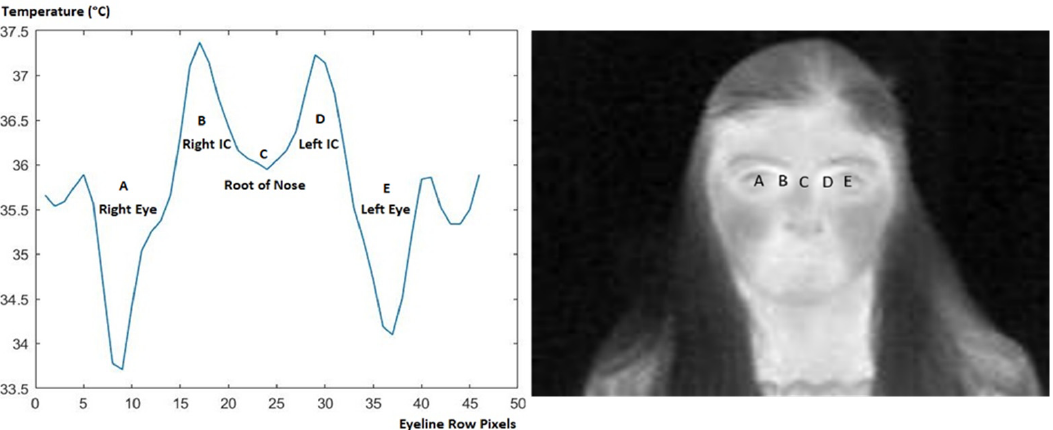
Figure 16. Temperature distribution along eyes line : Temperature of right and left eye, right and left inner canthus (IC) and the root of the nose.